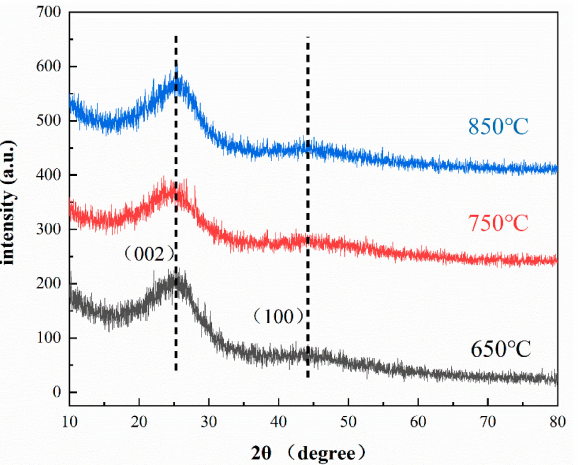
Figure 9. XRD spectrum of N-doped layered porous carbon at 650 ◦ C, 750 ◦ C and 850 ◦